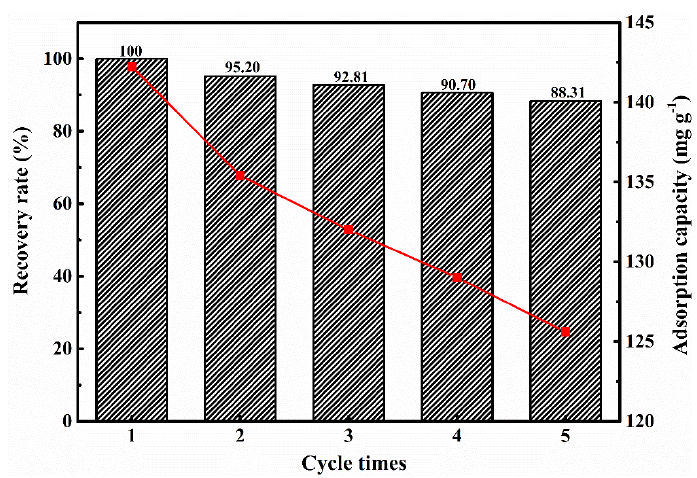
Figure 11. Repeated adsorption experiment of Li + by GO − CE − CS − PVA.